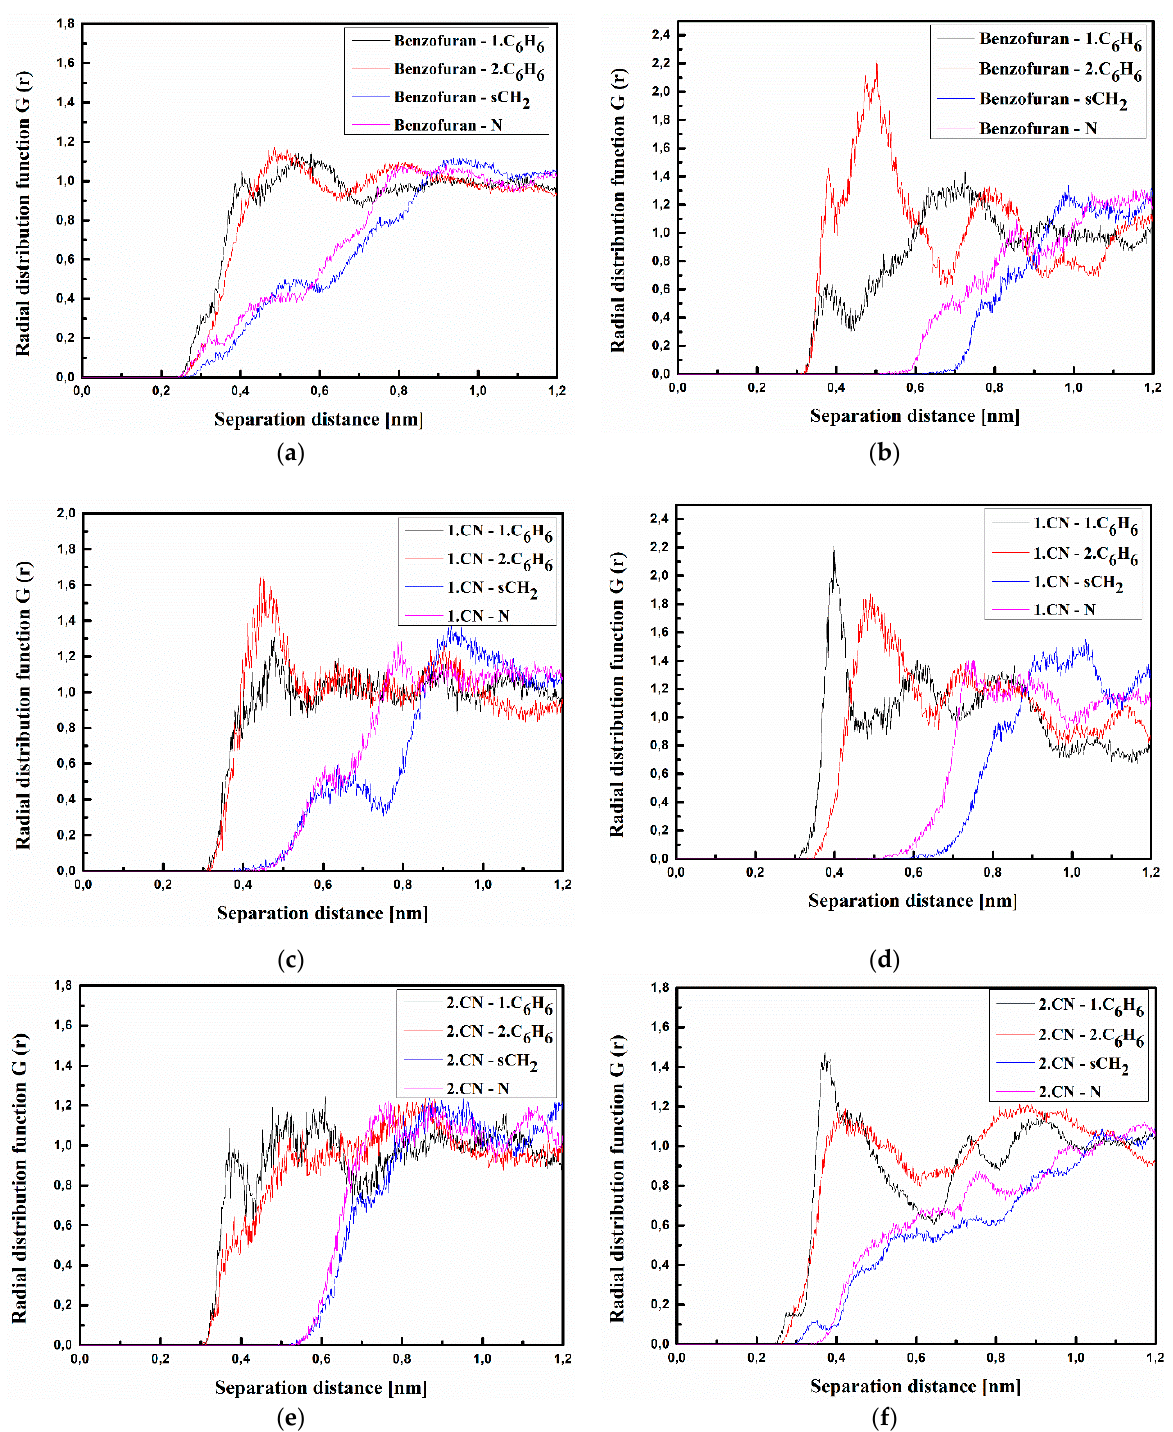
Figure 4. Partial RDFs calculated for distances between the center of mass of different moieties of the B molecule and different subunits of PVK at T = 500 K ( a , c , e ) and T = 300 K ( b , d , f ) for the bulk system. The RDFs are presented for the benzofuran group of the B molecule and different subunits of PVK mer ( a , b ); for cyanovinyl CN1 at the side of the molecule B and different subunits of PVK mer ( c , d ), and cyanovinyl CN2 at the back of the molecule B and different subunits of PVK mer ( e , f ). Molecule C is also located at a distance of 0.4 nm from the side groups of the polymer chain (see Figure 5). In addition, here, the polymer is also twisted, keeping the carbazole group outside the twisted chain. In the liquid state (see Figure 5a), the carbazole group of